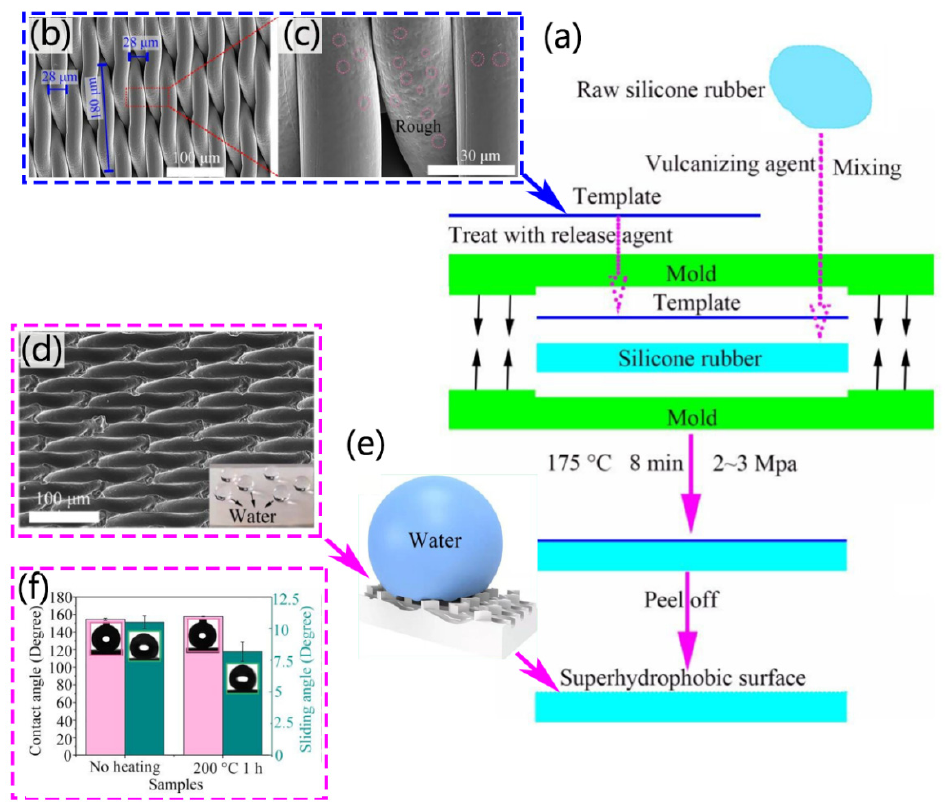
Figure 4. Fabrication of superhydrophobic insulators by template method. ( a ) Making a flow chart. ( b , c ) SEM image of a stainless steel mesh template. ( d ) SEM image of a superhydrophobic insulator. ( e ) Superhydrophobic model of a composite insulator. ( f ) Contact angle of a composite insulator.